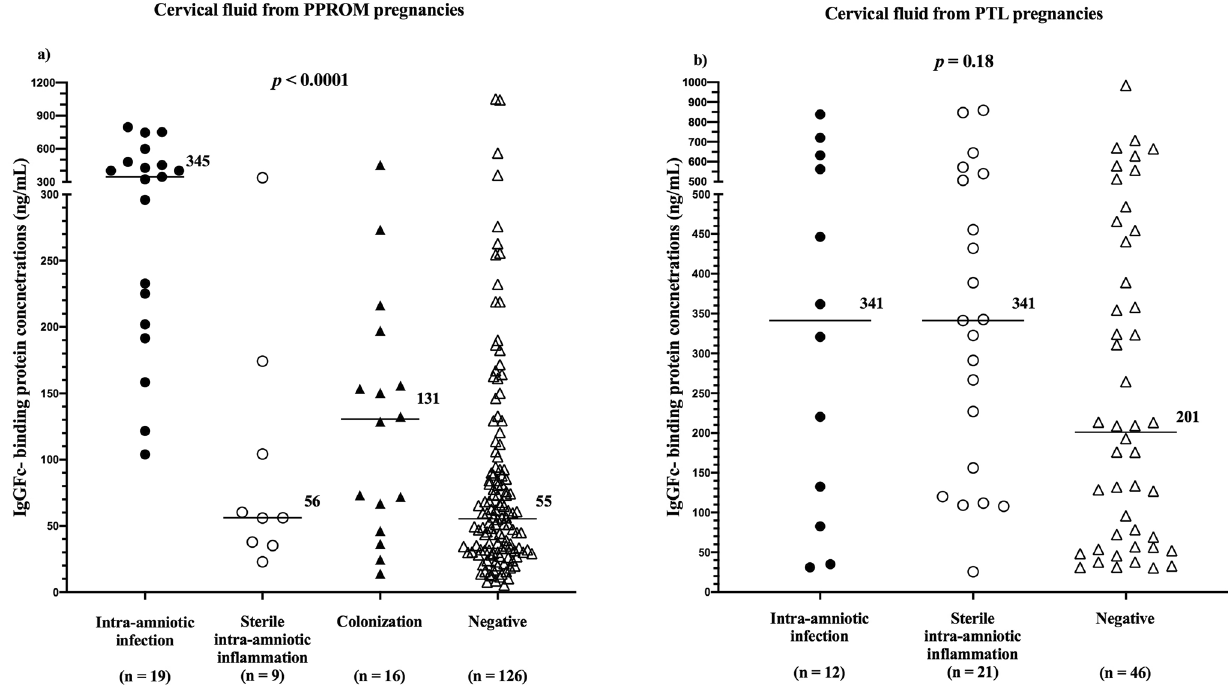
Figure 4. Cervical fluid IgGFc-binding protein concentrations in the subgroups of the women with PPROM ( a ) and with PTL ( b ). PPROM, preterm prelabor rupture of membranes; PTL, preterm labor with intact membranes.